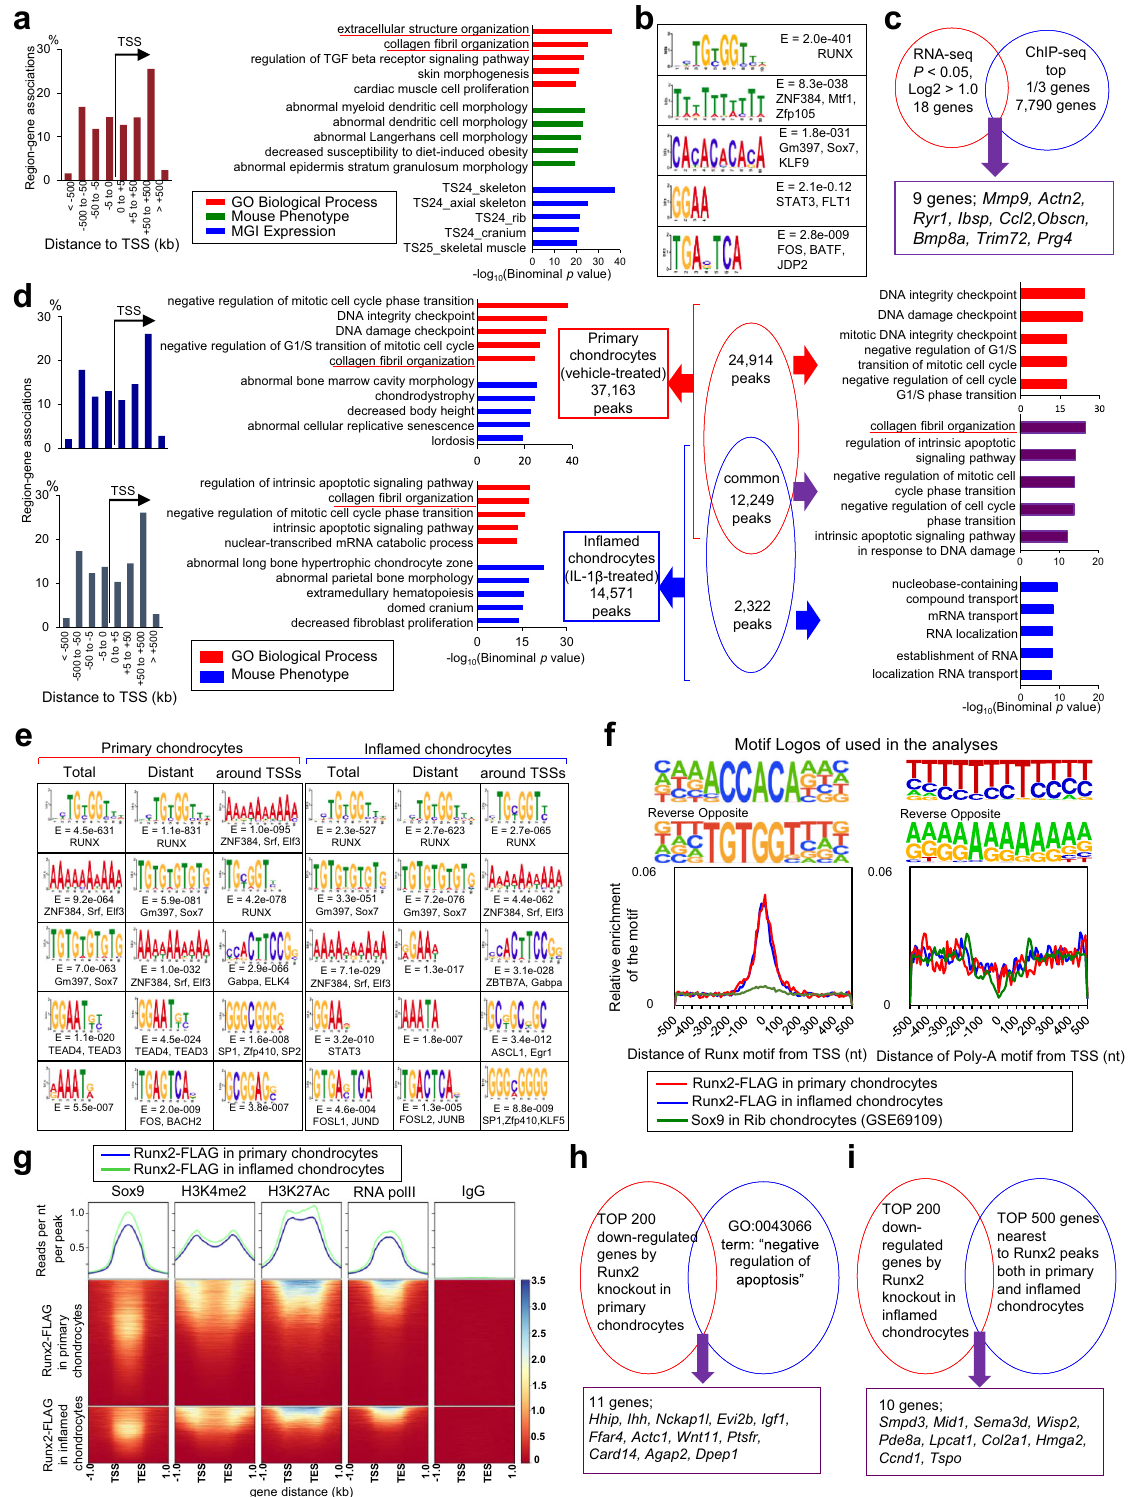
Distance of Runx motif from TSS (nt)